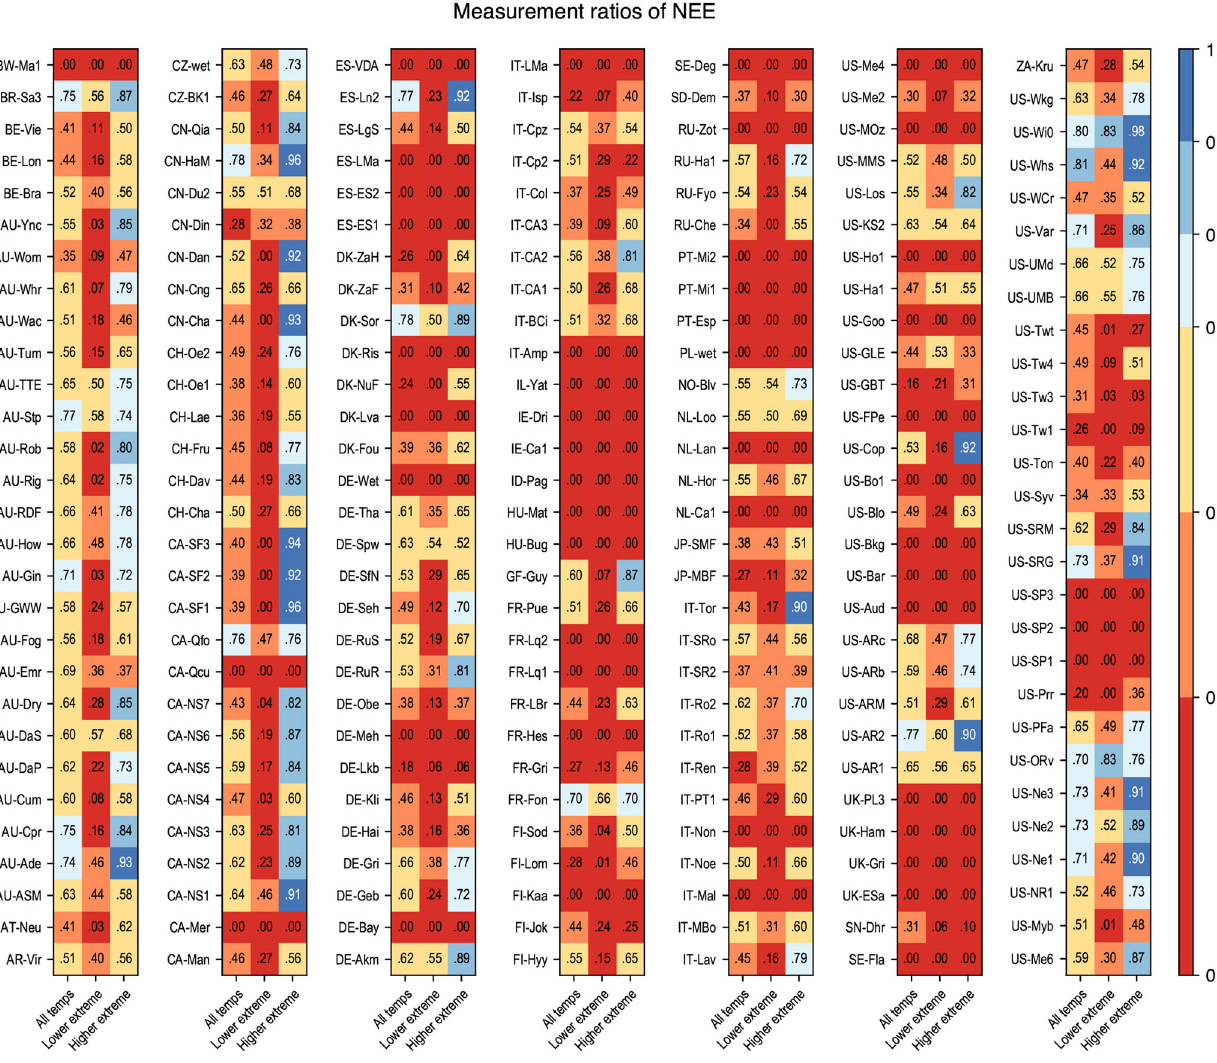
Figure 8. NEE measurement ratios of flux tower sites for all temperatures, the lower extreme temperatures and the upper extreme tempera-